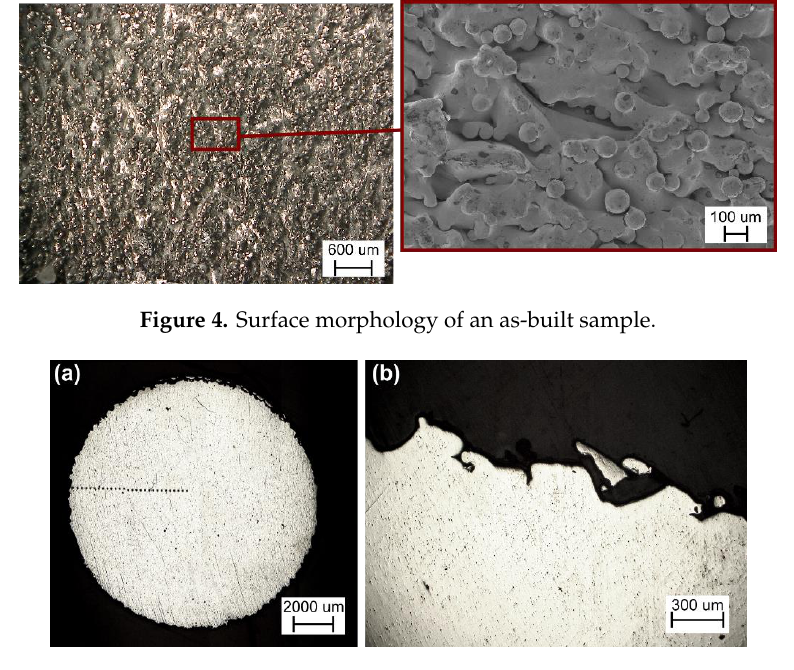
Figure 5. ( a ) Cross-section of as-built sample; ( b ) magnification of the external